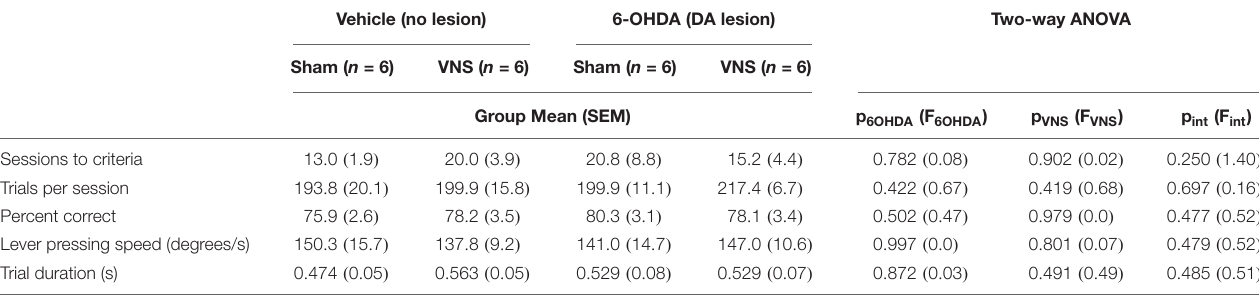
TABLE 1 | Behavioral performance during acquisition did not differ across treatment groups.